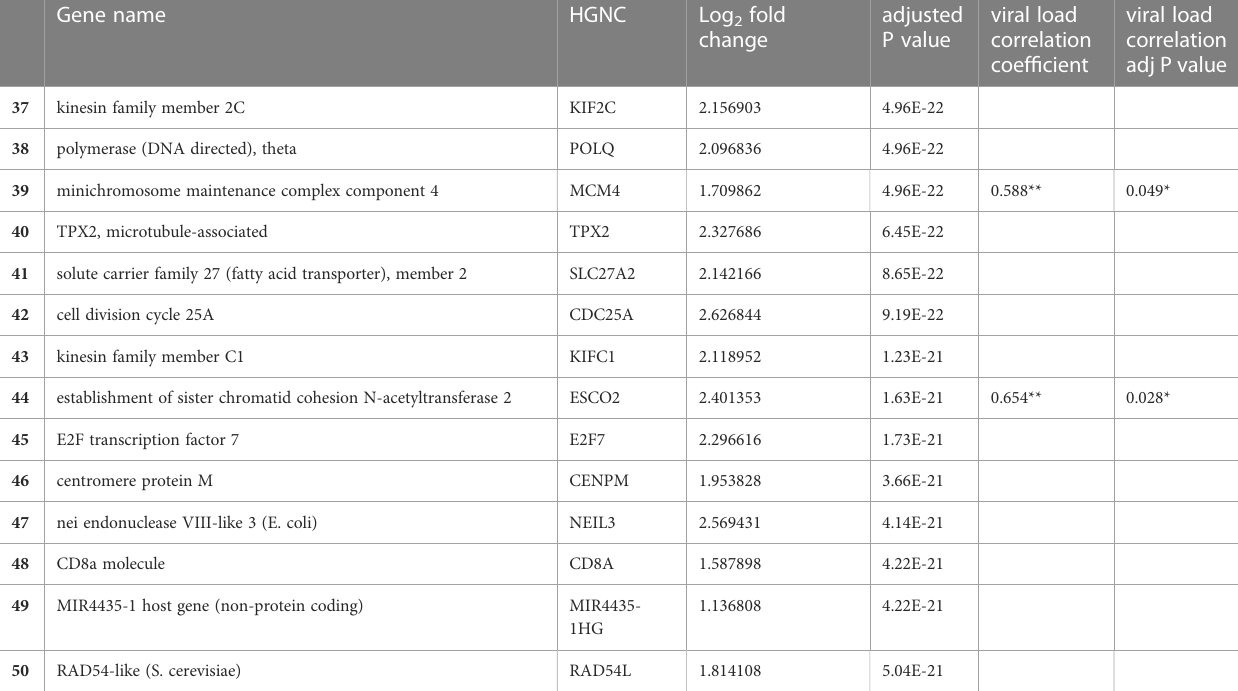
Gene expression data were used to estimate constituent cell populations within PBMC samples using in silica deconvolution tool CIBERSORT (Newman et al., 2015; Newman et al., 2015) (Figure 5A). Among PBMC from acute HIV cases, CD4+ T cells contributed median 24.3% of cells, CD8+ T cells contributed 22.2%, and B cells contributed 4.5%. These were signi fi cantly different from